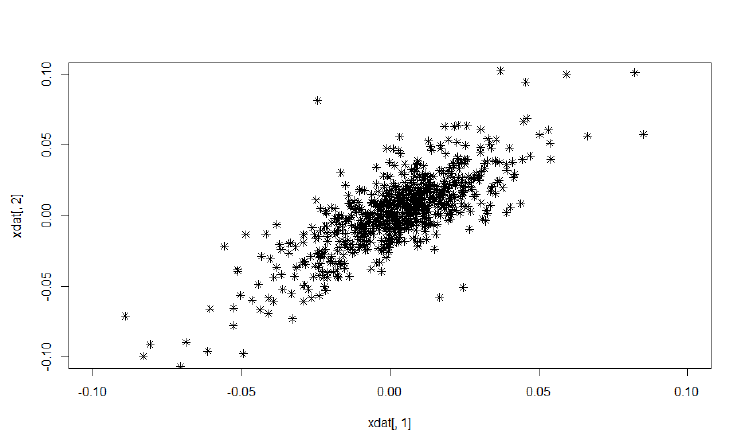
These figures and the ˆ ρ values show that the fitting was